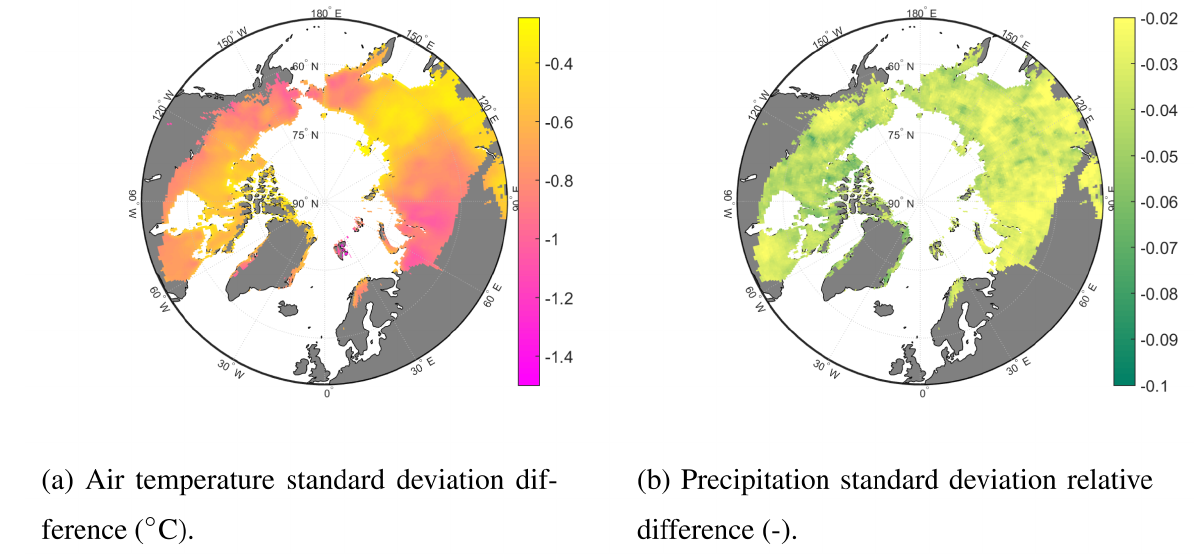
Figure 5. Comparison of 1980–2009 standard deviations of meteorological variables (REDVAR − CNTL) or (REDVAR −